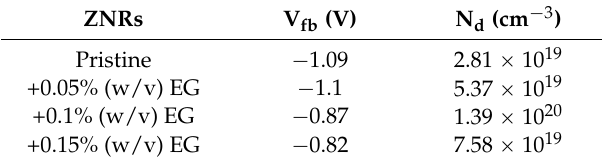
Table 1. Influence of EG doping on flat band voltage (V fb ) and the doping density (N d ) of